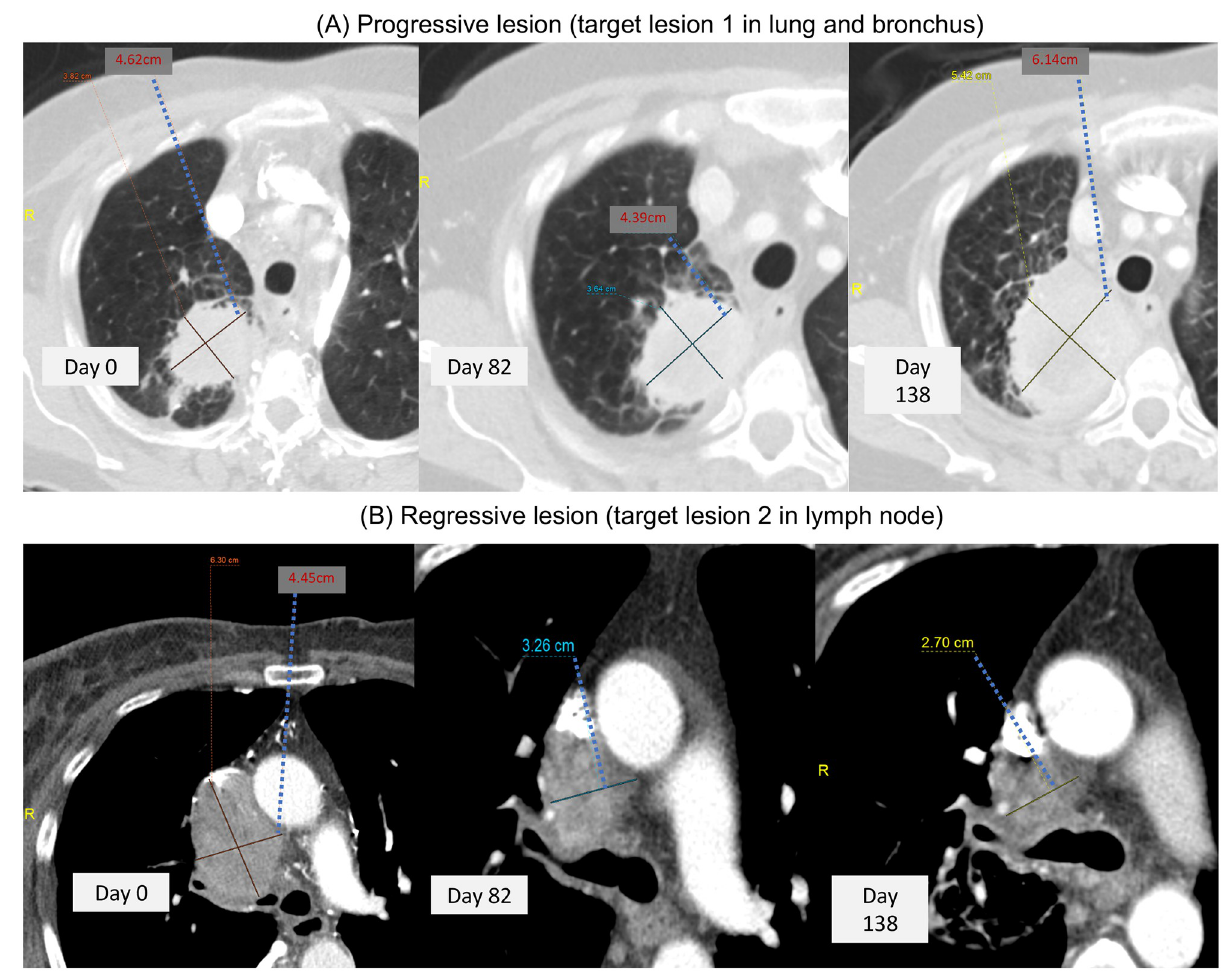
Fig 1. Lesion heterogeneity in CT image for Case A. (A): Illustrative image data of a progressive lesion for Case A. The lesion was target lesion 1 in lung and bronchus from three time points and demonstrated eventual progression of disease by RECIST criteria. The tumor growth pattern was also displayed in Fig 2A in black color dashed line. (B): Illustrative image data of a regressive lesion for Case A. The lesion was target lesion 2 in lymph node at three timepoints and showed continued decrease in size of lesion consistent with response to treatment. The tumor growth pattern was also displayed in Fig 2B in red color dashed